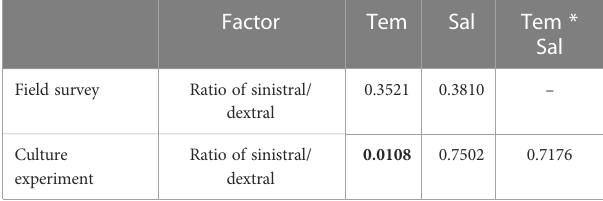
TABLE 1 p -values for effect of temperature (Tem) and salinity (Sal) on ratio of sinistral/dextral in A. aomoriensis from fi eld survey and culture experiment.